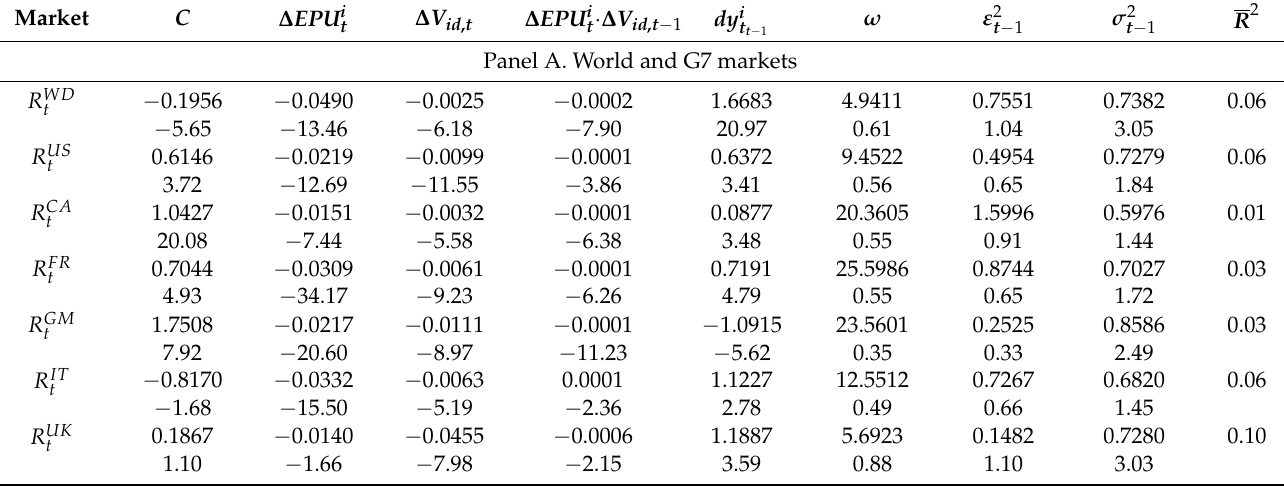
Table 7. Estimates of stock returns in response to changes in economic policy uncertainty and volatility of infected disease and interacting